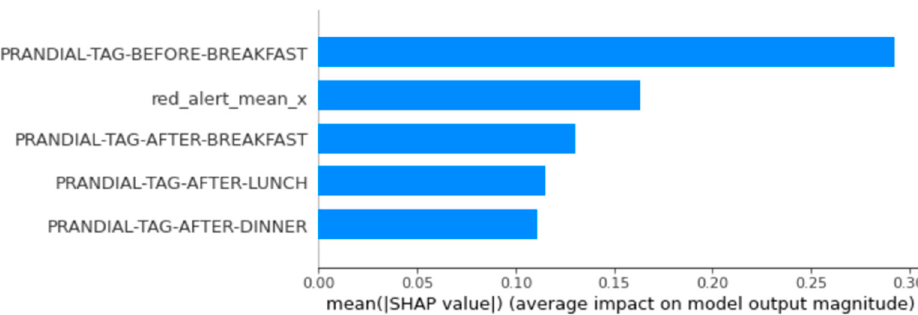
Figure A2. SHAP feature importance ranking for model trained on Tags and Gradients.